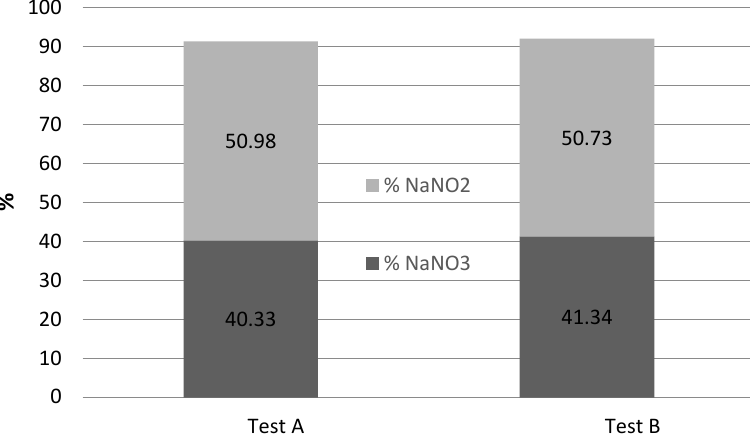
Figure 10. DSC curve for products crystallized from NO x gases in Test A.